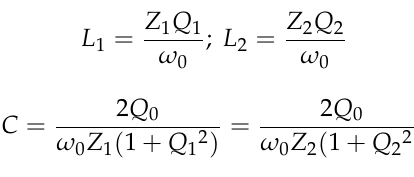
Figure 12. Frequency response of PA with matching.